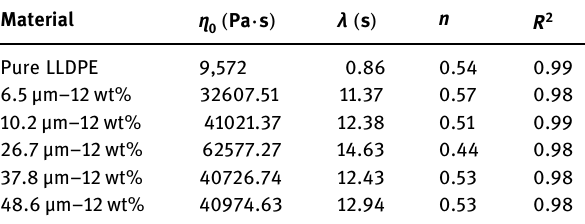
Table 3: Fitting results for the Al 2 O 3 /LLDPE composites